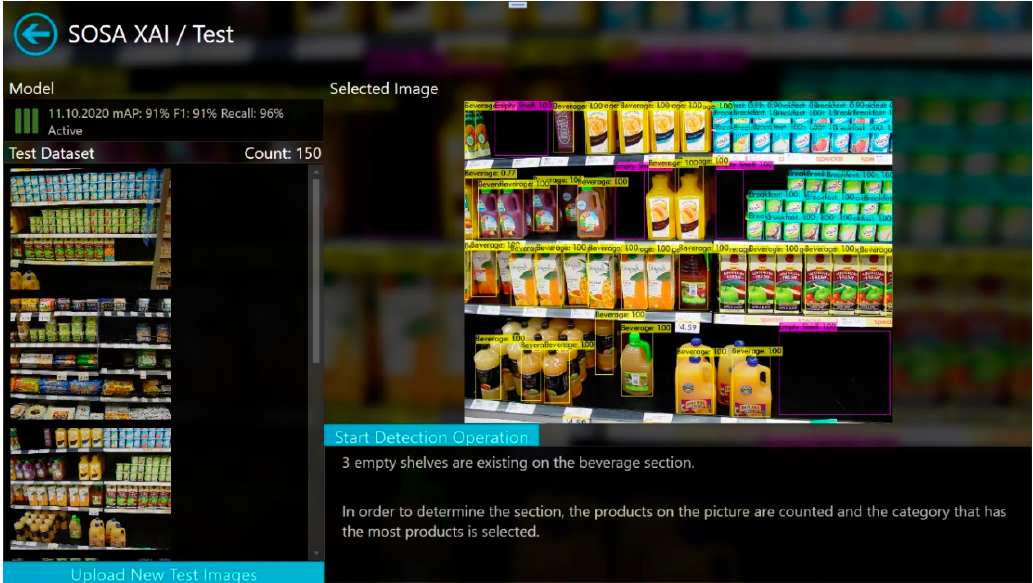
Figure 5. Test screen of SOSA XAI.